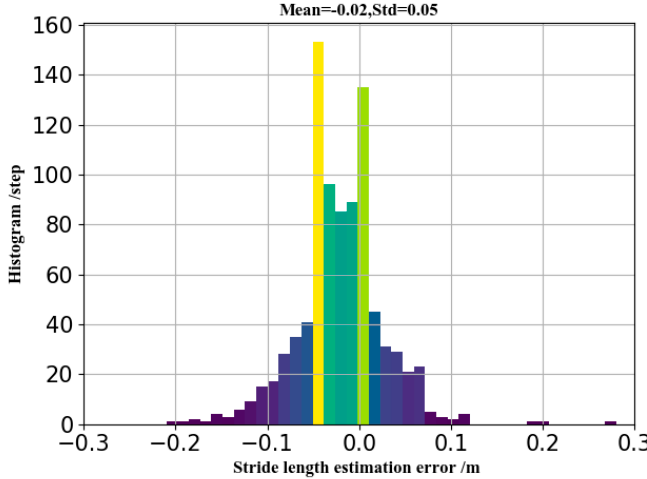
Figure 18. Estimation error distribution of stride-length.